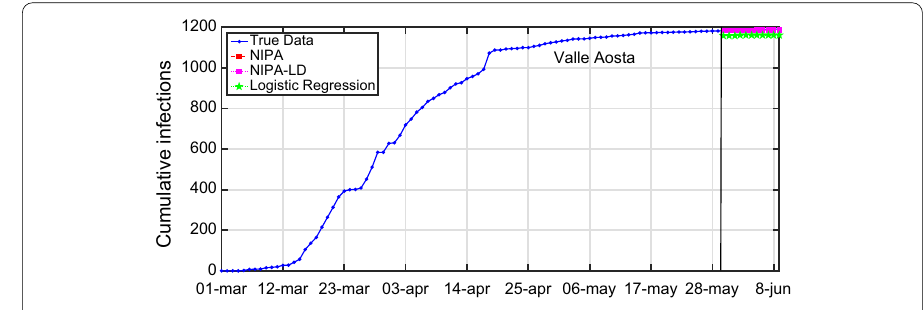
Fig. 11 Cumulative deaths for Lombardia with n neglect = 30